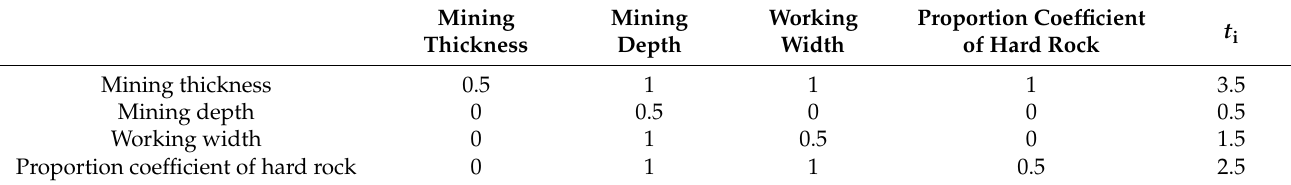
Table 4. Qualitative judgment table of index ranking consistency of fixed weight factor set U